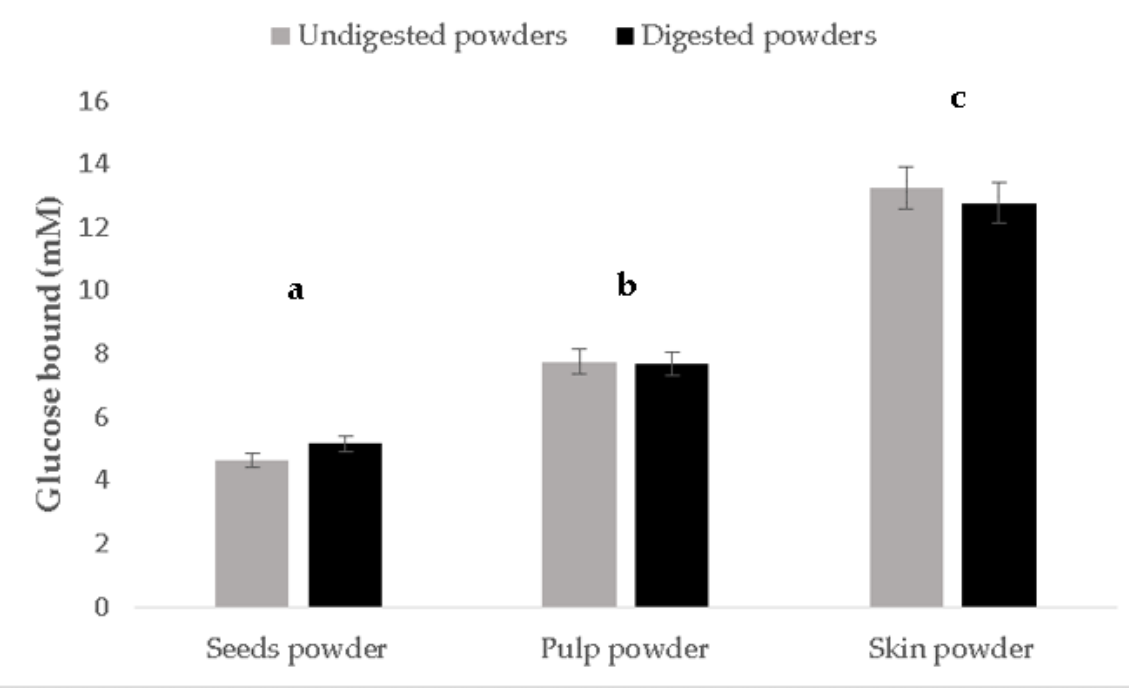
Figure 2. Glucose adsorption capacity (determined by measuring the mM of glucose in dialysate) of digested and undigested mistol powders. Values are presented as mean ± SEM and scrutinized by 1 or 2-way ANOVA, followed by a Tukey or LSD test using R studio software. Different letters on the bars indicate significant differences between the three parts of the fruit, evaluated according to Tukey’s test ( p ≤ 0.05). No significant differences ( p ≤ 0.05) were observed between digested and undigested powders.